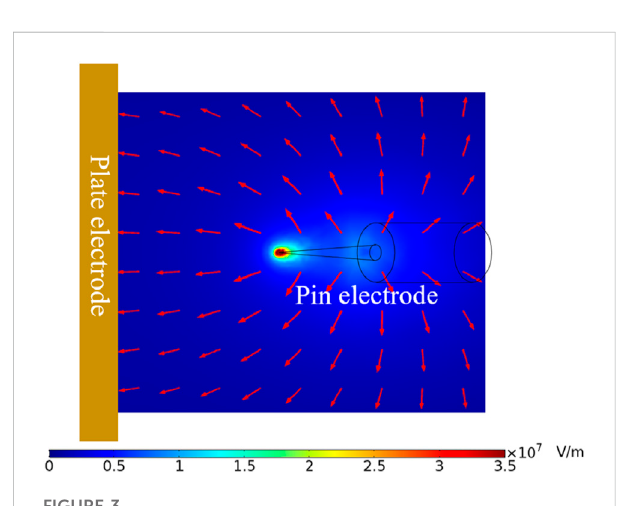
FIGURE 3 Electric fi eld distribution on the surface of cardboard at 32 kV.